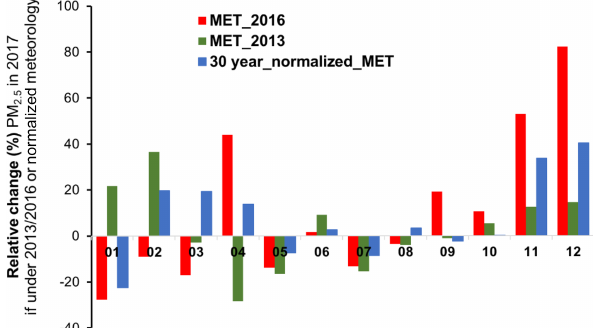
Figure 4. Relative change in monthly PM 2 . 5 levels in 2017 under different weather conditions. This figures presents relative changes